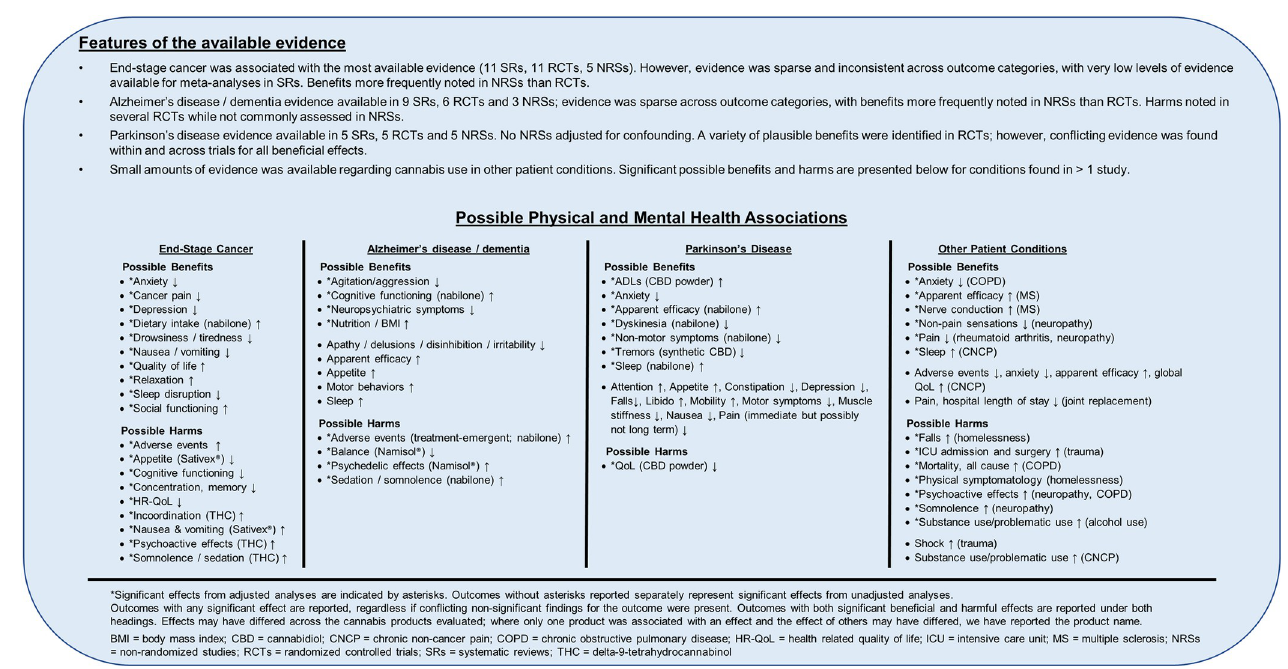
Fig 4. Synopsis of findings reported in studies of cannabis use in unique patient conditions and